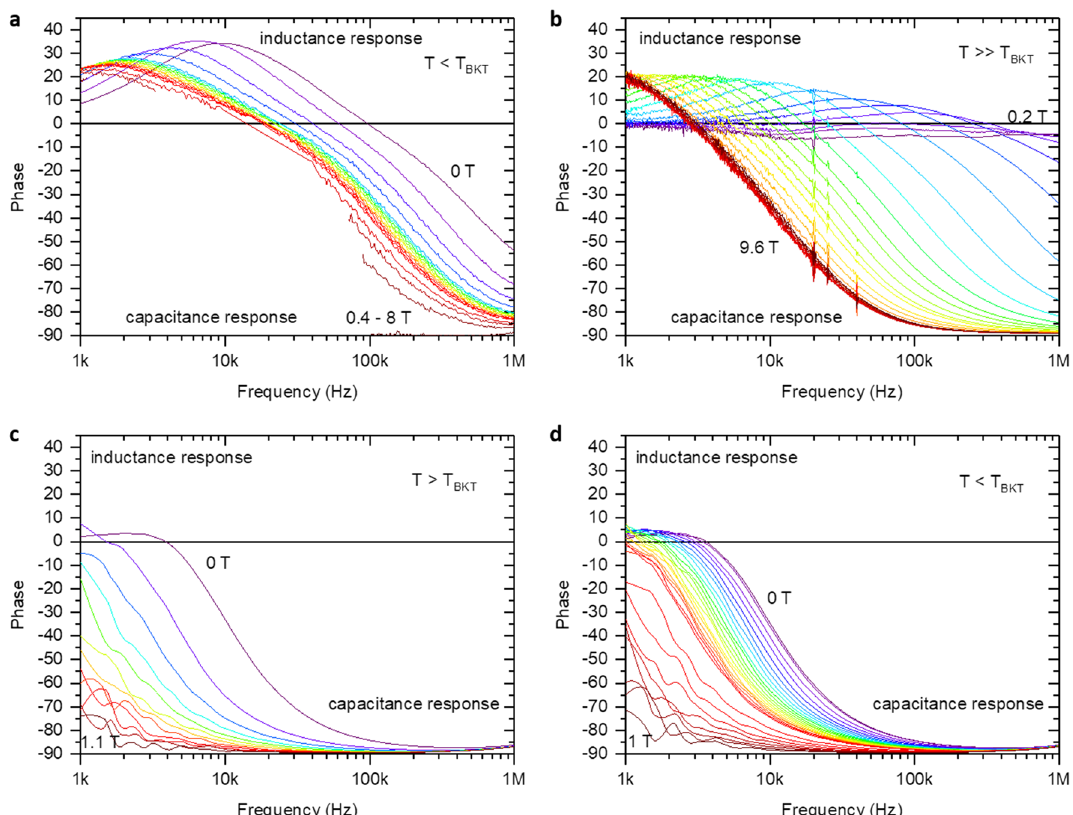
Figure 4. Frequency dependence of the phase of the complex impedance of the NbTiN films. Measurements were performed between contacts separated by the distance 2.5 mm. For all samples, we observed the evolution from inductive to capacitive response with increasing frequency. With increasing the magnetic field, the capacitive response dominates over the inductance response. ( a ) Sample U. Phase = 90 in magnetic field 0.4–8 T at temperature 35 mK. ( b ) Sample N1 at temperature 200 mK. ( c ) Sample N2. Phase = 90 in magnetic field 1.1–8 T at temperature 200 mK. ( d ) Sample N2. Phase = 90 in magnetic field 1–8 T at temperature 200 of inductance and minima of capacitance at fields corresponding to the maxima of the magnetoresistance. This